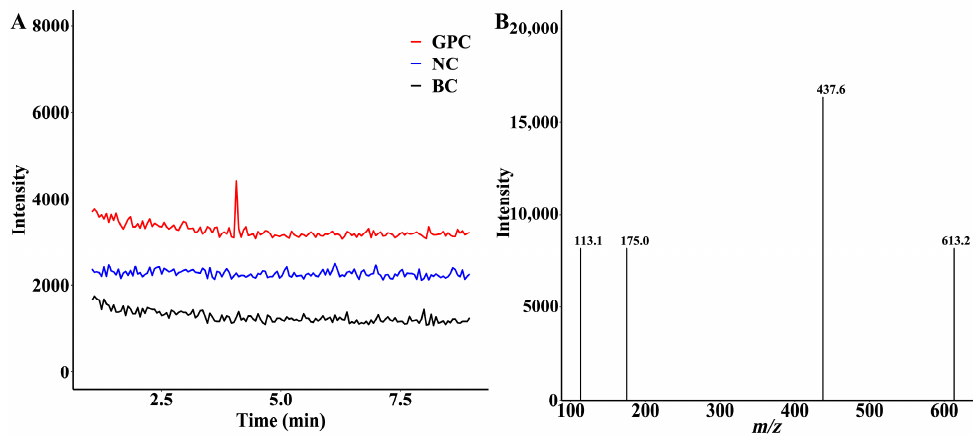
Figure 2. Glucuronidation metabolites of GPC in human liver microsomes. ( A ) LC–MS/MS chroma- togram of the extract of the incubation system. ( B ) MS/MS spectra extracted from the chromato- graphic peak of GPCG at the retention time of 4.07 min.